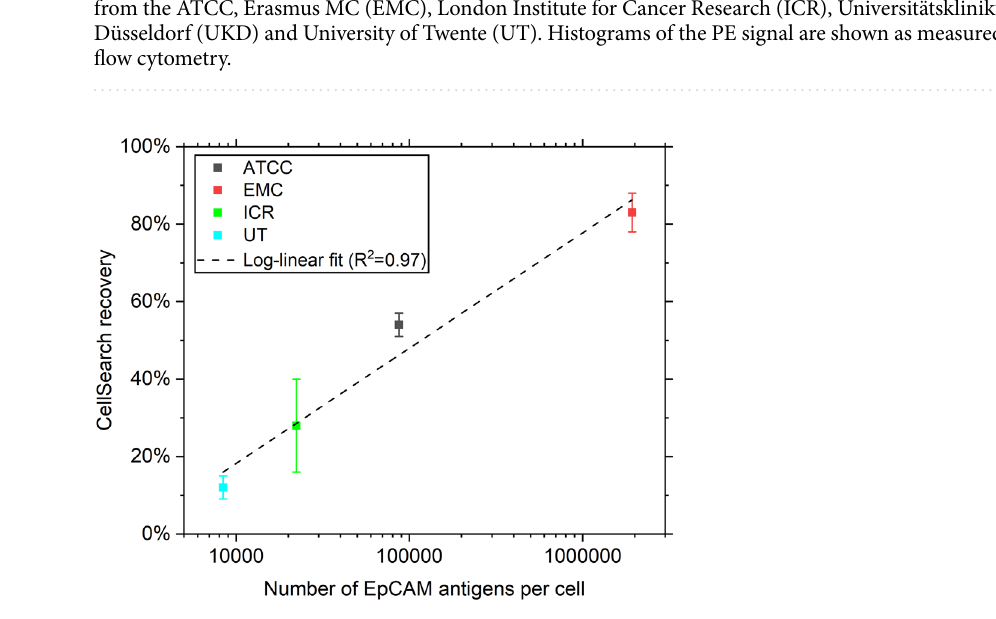
Figure 4. EpCAM expression of PC3 from the ATCC, Erasmus MC (EMC), London Institute for Cancer Research (ICR) and University of Twente (UT) together with the CellSearch recovery of each of the cell lines. N = 3. Error bar indicates mean ±